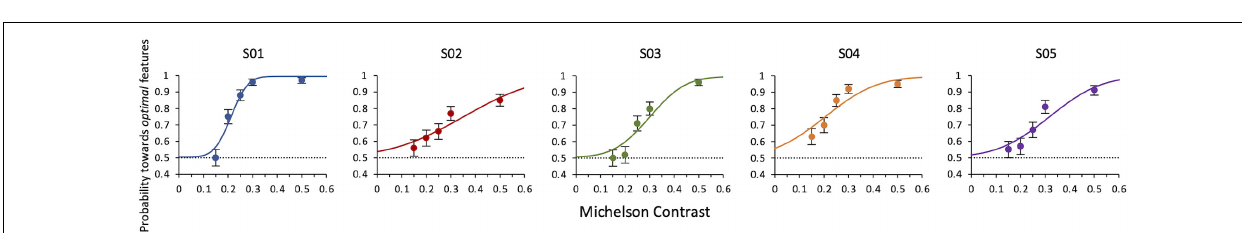
FIGURE 5 | Experiment 2: Probability of selecting the target as a function of SNR. Data from individual observers. The dashed line indicates the guessing level for this task (0.5 probability). Target SNR could be 0.1, 0.4, 0.6, or 1 (corresponding to 1, 4, 6, or 10 optimal features in the target compound out of 10 total features).